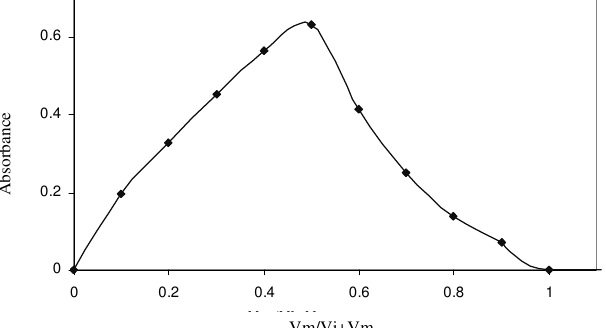
Figure 12. Determination of the stoichiometry of the reaction of: Gabapentin (1.25 x 10 -3 M) and bromothymol blue (1.25 x 10 -3